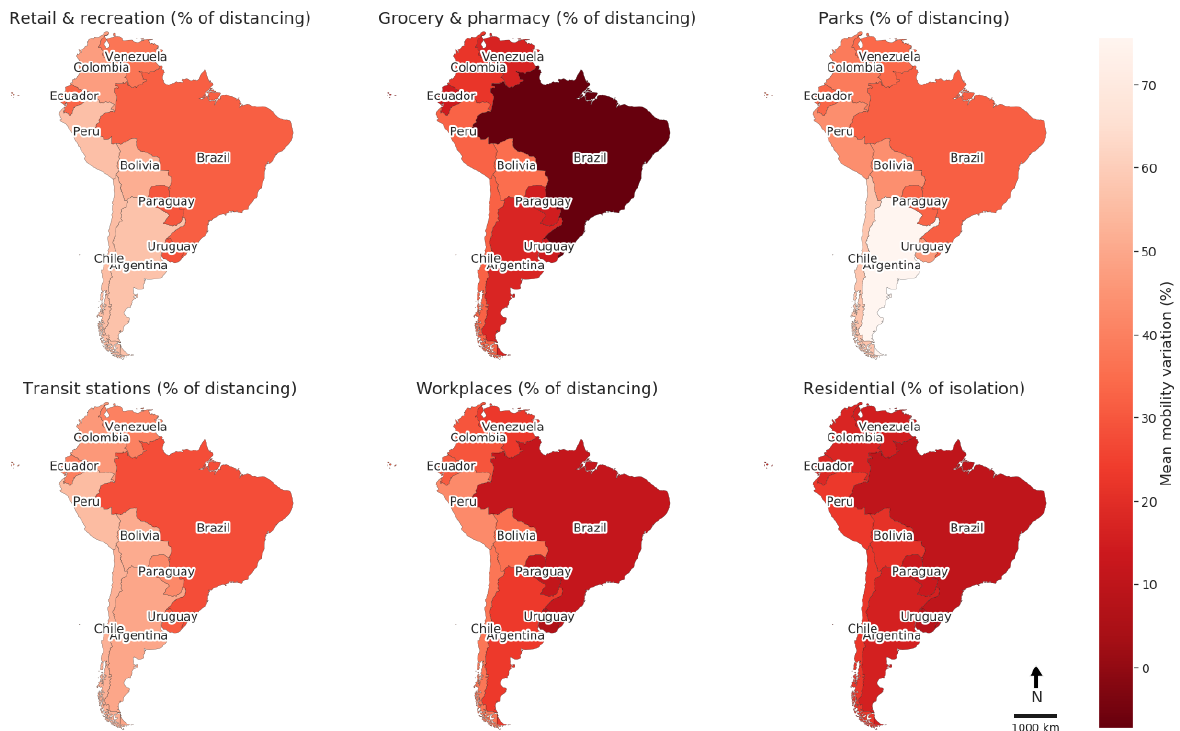
Figure 12. Average variation of mobility from baseline (3 January to 6 February 2020) for the selected countries of South America during the period from 1 June to 27 October 2020. Lighter colours indicate greater distancing or greater isolation in residential areas. Source of basic data: Covid-19 Community Mobility Reports,